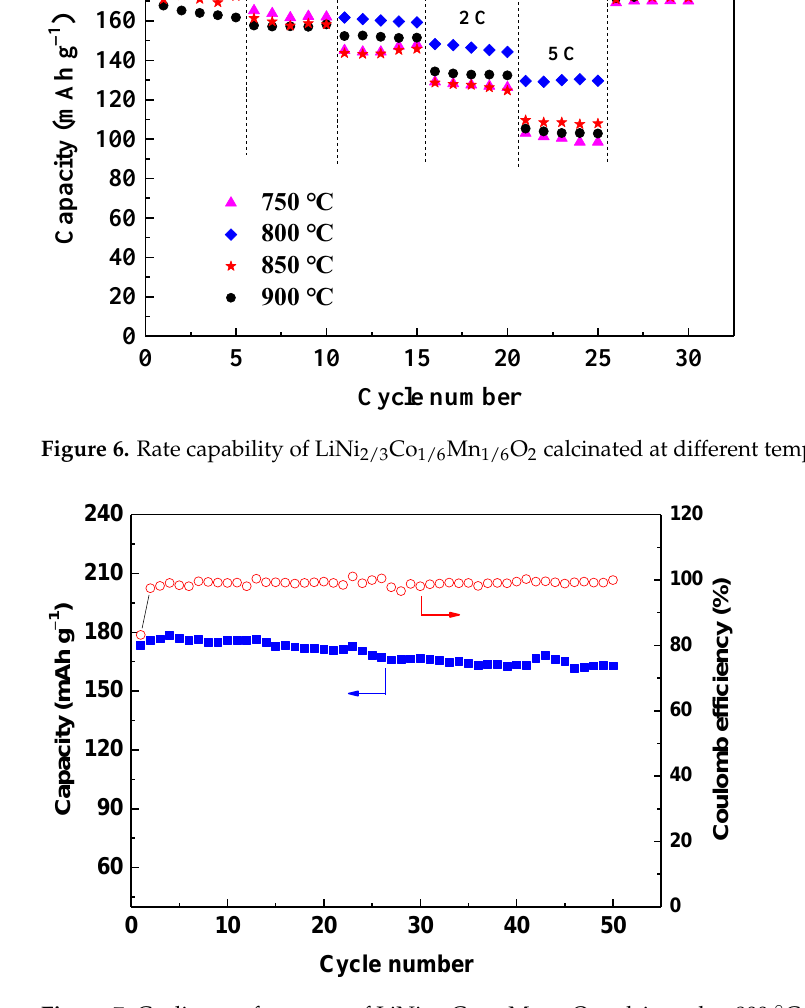
◦ 2/3 Co 1/6 Mn 1/6 O 2 calcinated at 800